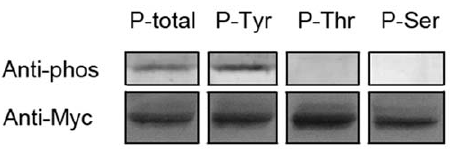
Figure 7. Detection of specificity of phosphoproteins in TNNI3K. Myc-tagged TNNI3K was overexpressed in H9C2 cells. TNNI3K proteins were immunoprecipitated with anti-myc antibody and Western blotted with anti-phosphoamino acid antibody (P-total), anti-phospho- tyrosine antibody (P-Tyr), anti-phosphothreonine antibody (P-Thr), anti- phosphoserine antibody (P-Ser) (top panel) or anti-myc (bottom